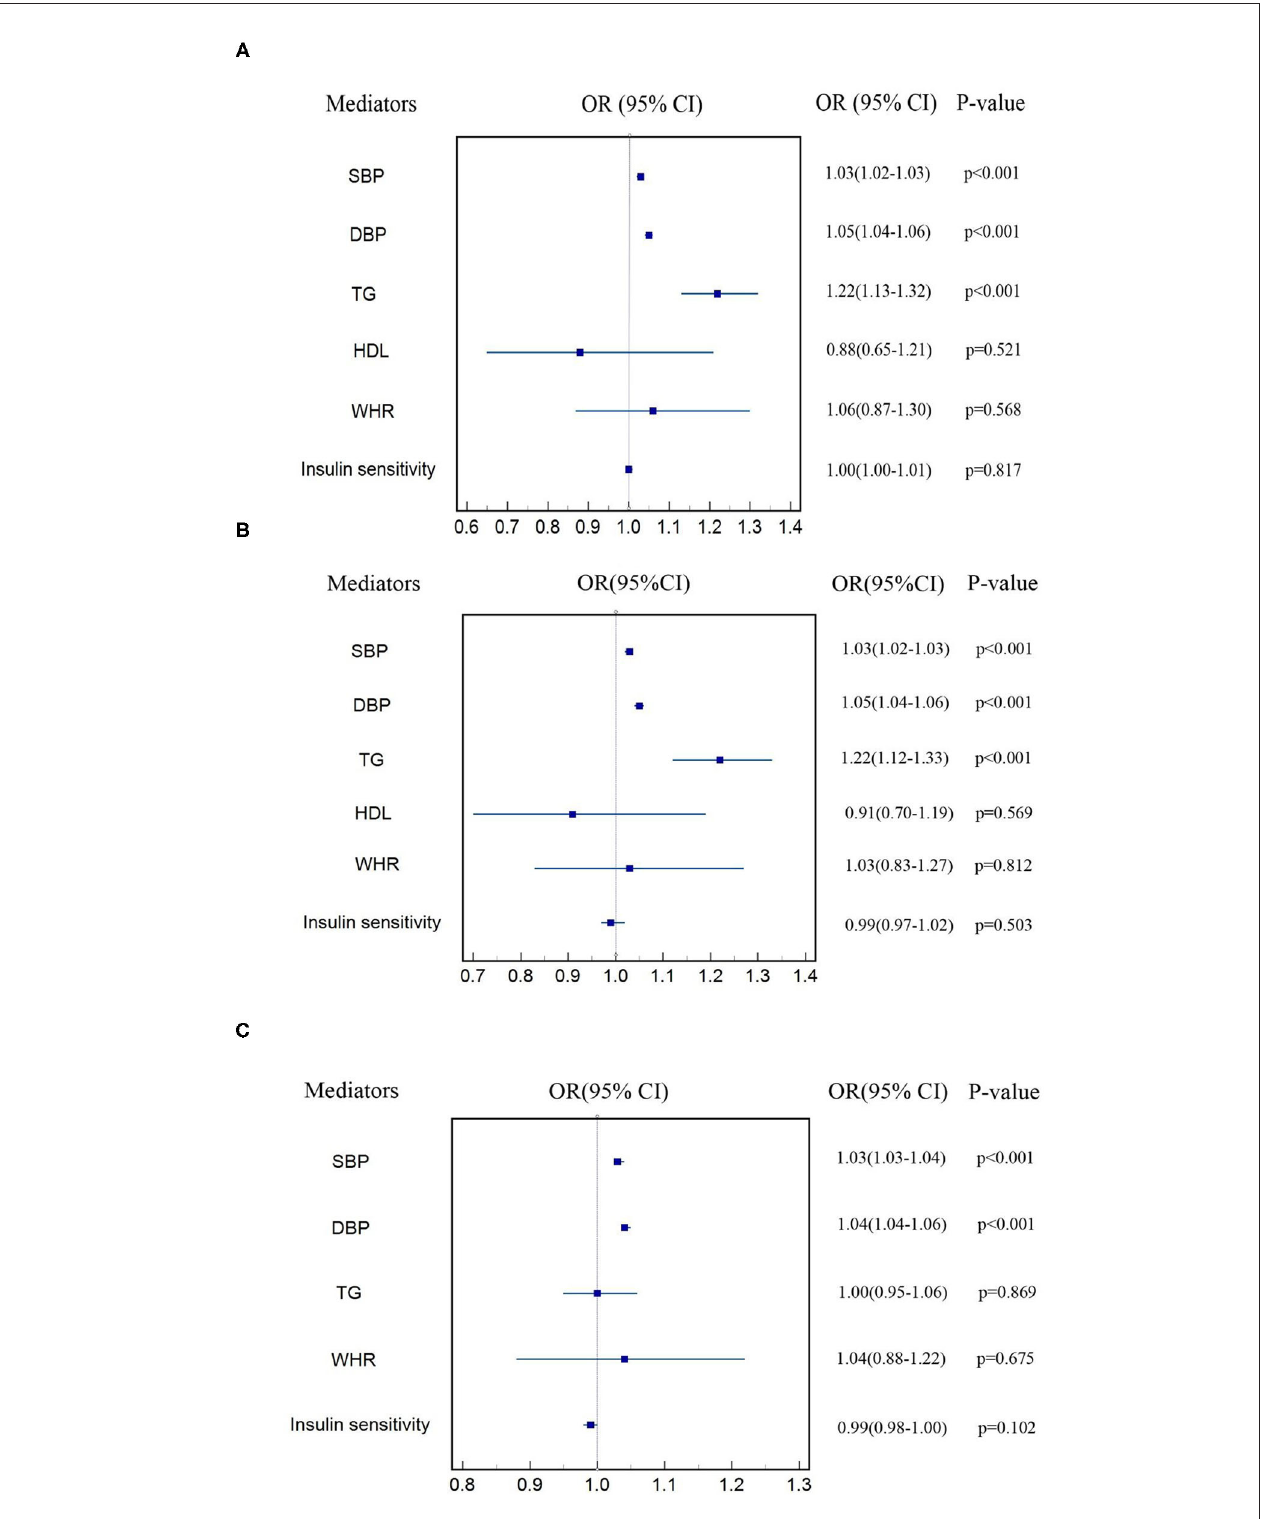
FIGURE 3 | Estimate of effect of cardiometabolic factors on each subtype of CVD (A) CHD, (B) MI, (C) stroke.